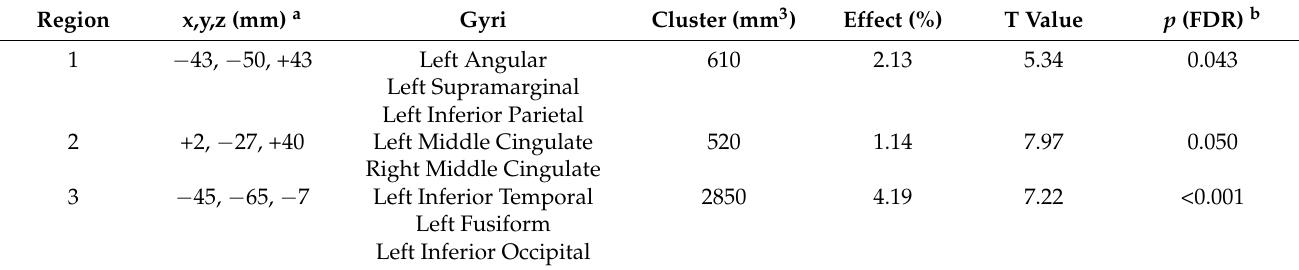
Figure 2. Brain tissue changes over the year that included 15 weeks of the FIE cognitive training. ( A ) Increased GM concentrates in left posterior regions surrounded by decreased CSF. Increased WM extended to the dorsal parts of both hemispheres. Clusters of GM with a higher statistical significance, located on the anterior occipital-lobe border and cingulate cortex are listed in Table 1 ( p < 0.05, FDR corrected, numbered 1–3). ( B ) Decreased GM was prominent bilaterally in the fronto-basal and in the right temporal regions. Increased CSF was prominent in the lateral ventricles and Sylvian fissures. Table 2. Increase in grey matter at one year post-baseline in MCI patients who participated in the FIE Program. Region x,y,z (mm)